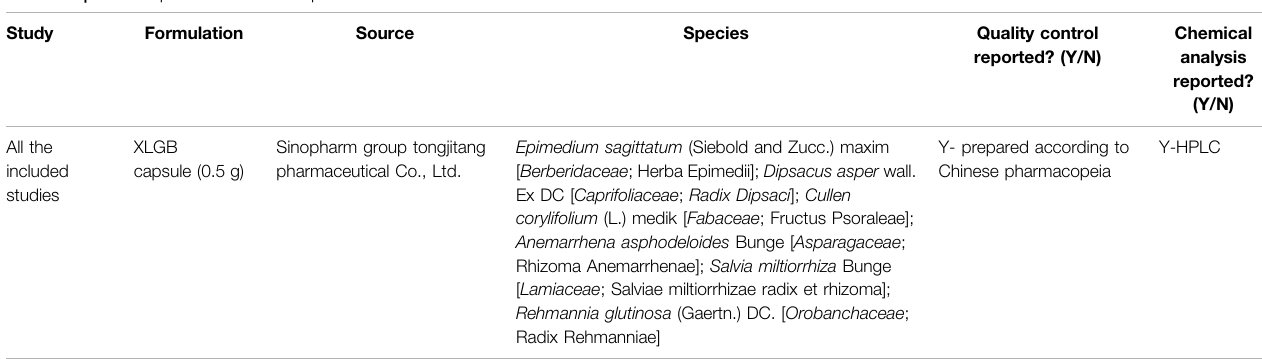
TABLE 2 | The composition of XLGB